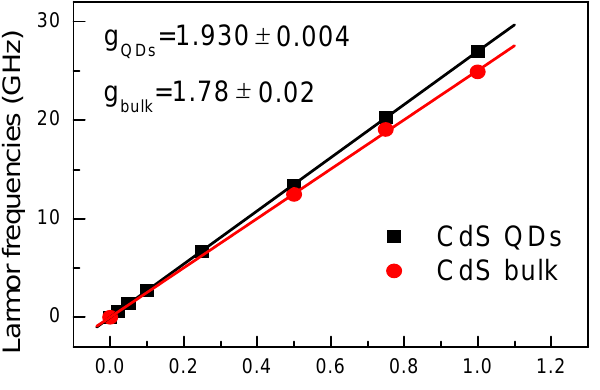
Figure 4. Magnetic field dependence of time-resolved Faraday rotation (TRFR) oscillation frequencies. Linear fits give information of g factor, with error obtained from the fit algorithm.